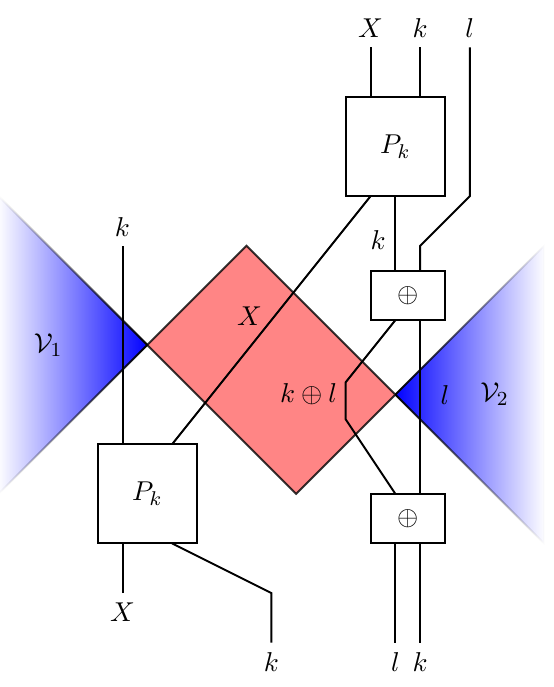
Figure 6. At an early time the bit strings l and k are prepared. Their sum mod 2, l ⊕ k , is sent directly through U to near r , while l is sent through V to near r . Meanwhile, k is sent near c then 2 onwards through V . Near c the string k is used to encode the message, which is then sent through 1 U . Meanwhile, near r , l and l ⊕ k are used to calculate k , which is then used to decode the message. This procedure leads to I ( V : V ) = 0 and I ( V : V ) 1 2 1 2 | U